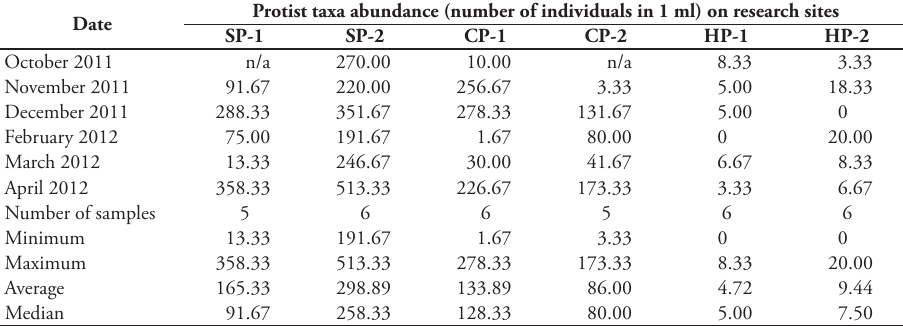
Figure 5. Taxon richness and abundance of protist taxa at the sites investigated. Table 2. Abundance of protist taxa at the investigated